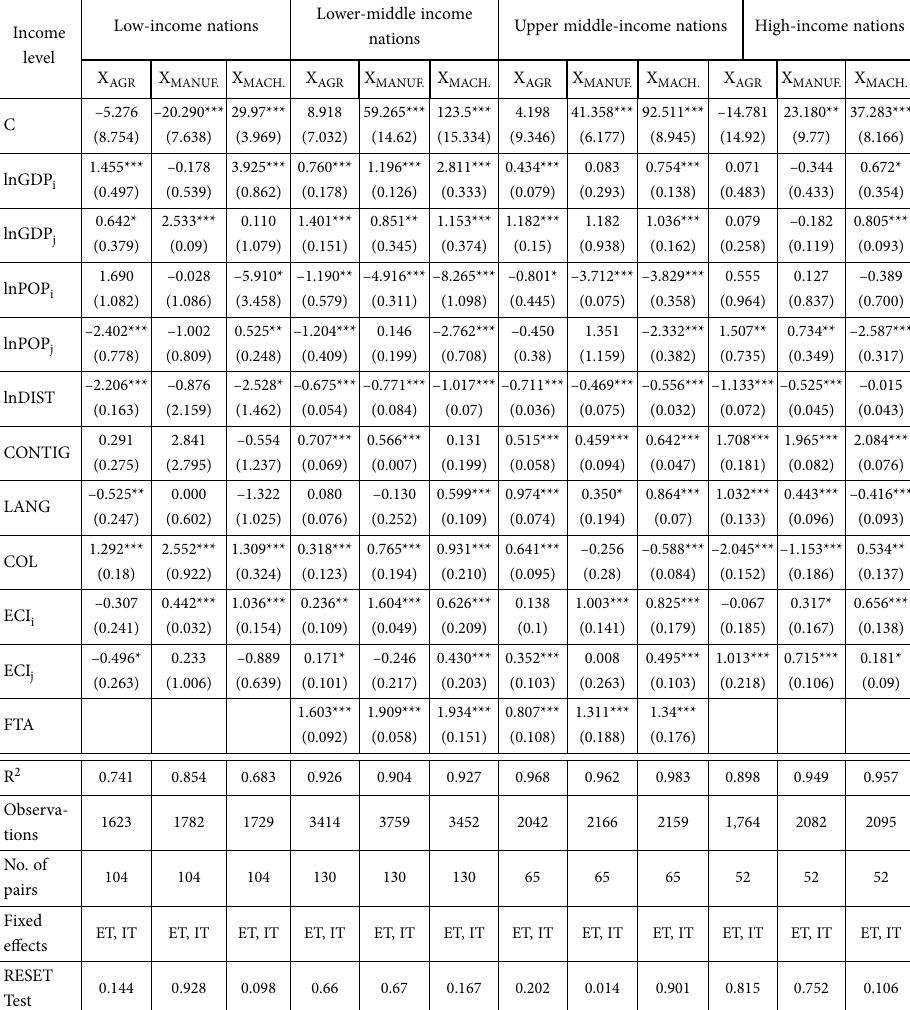
Table 5. Gravity model estimates of bilateral exports using PPML by income Lower-middle income Low-income nations Upper middle-income nations High-income nations